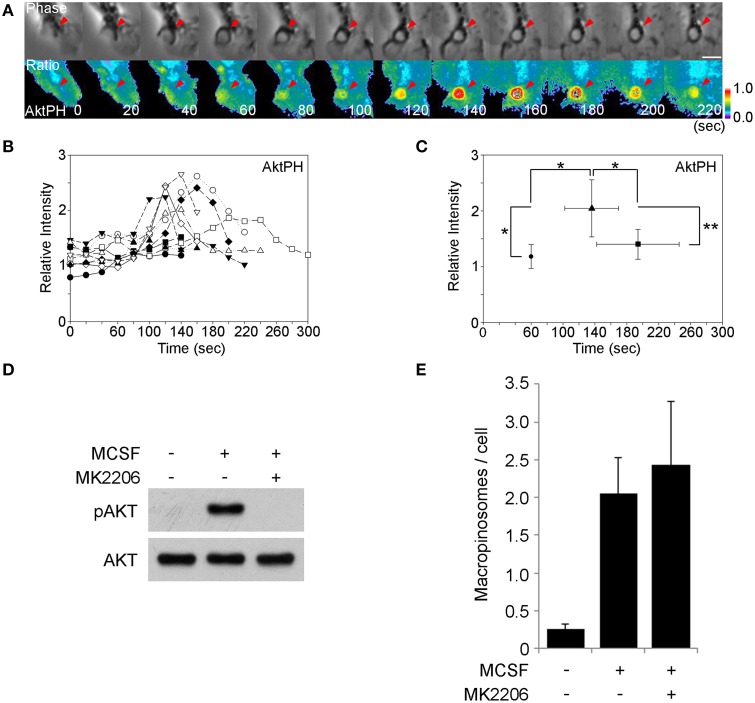
The M-CSF-induced Akt signal is not required for macropinosome formation. (A) BMM expressing CFP and YFP-AktPH were imaged during M-CSF-stimulated macropinocytosis. The beginning and end of ruffle closure occurred at t = 0 s and t = +60 s, respectively. The ratio images show YFP-AktPH recruitment to the macropinosome area. Bar: 5 μm. (B) Plots of Rmac/Rcell as a relative intensity of AktPH on macropinosomes (n = 10). 60 s marks the end of ruffle closure. (C) Plot of the average Rmac/Rcell of end of ruffle closure (•), the peak of the signal (▴), and the end of cup closure (■). Signal intensities of the peak were significantly higher than at the end of ruffle closure and the end of cup closure. * <0.05. ** <0.01. (D) Western blotting analysis showing Akt phosphorylation on Thr308 was induced within 5 min of M-CSF-stimulation and blocked by the Akt-specific inhibitor MK-2206. (E) The macropinosome assay showed that MK2206 treatment did not hinder M-CSF-induced macropinocytosis. Data are mean and S.E.M. of three trials, measuring >25 cells per trial.